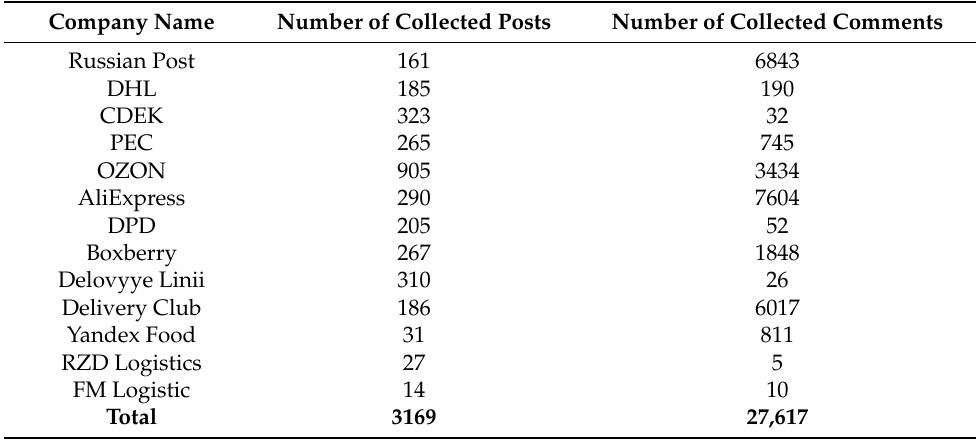
Table 5. Information on the amount of data collected for selected